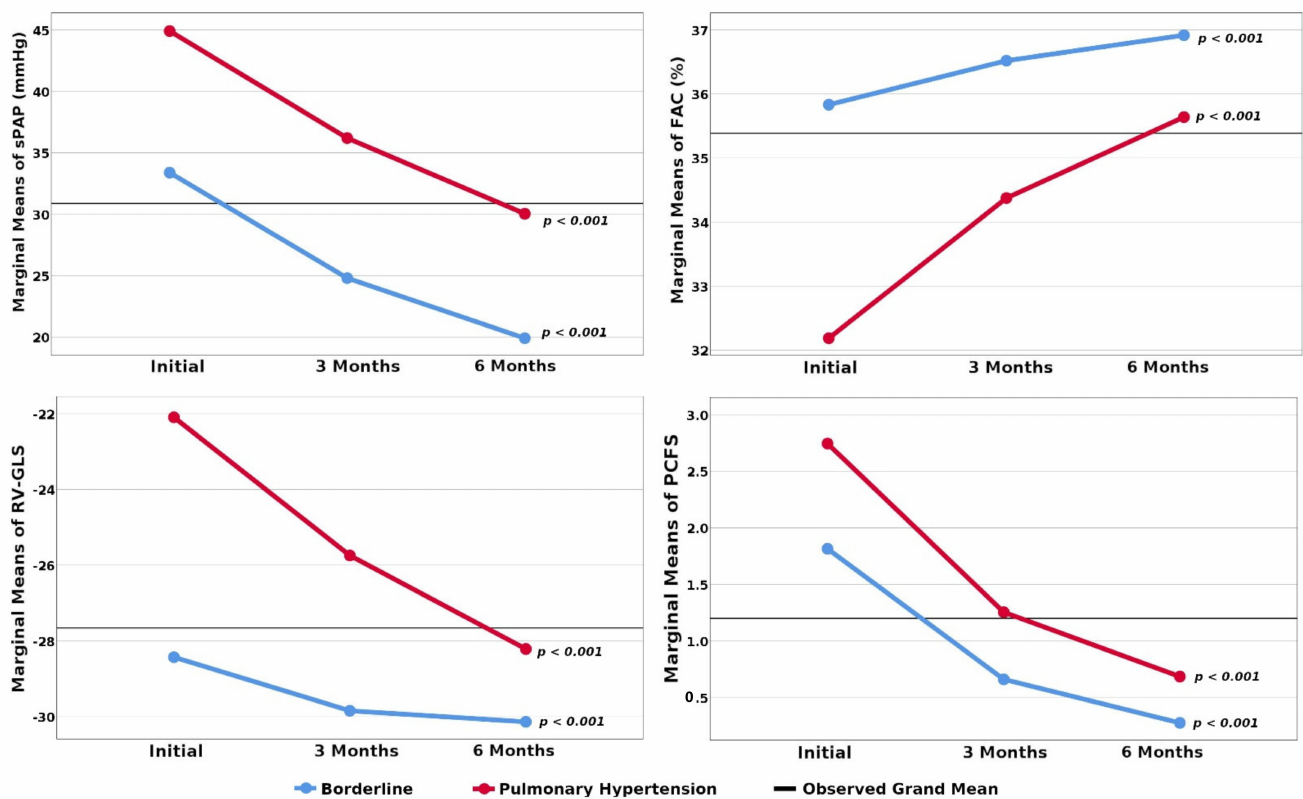
Figure 1. Evolution of patients’ characteristics at 3 and 6 months. Legend: esPAP—echocardigraphically estimated systolic pressure in the pulmonary artery; FAC—fractional area change; RV-GLS—right ventricular global longitudinal strain; PCFS—Post-COVID-19 Functional Status; p -statistical significance of Friedman